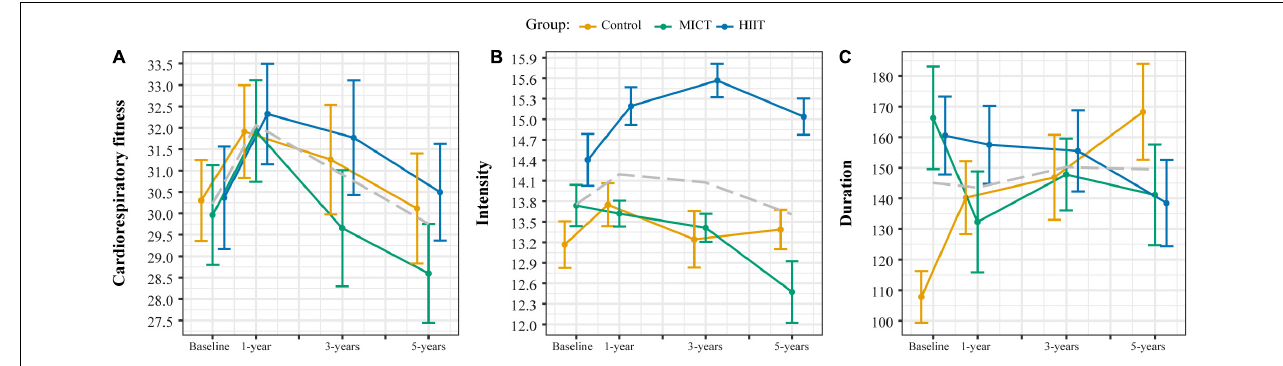
FIGURE 2 | Cardiorespiratory fitness (A) , exercise intensity (B) measured with the Borg 6–20 scale, and exercise duration (C) measured as minutes per week in the control, moderate-intensity continuous training (MICT), and high-intensity interval training (HIIT) groups at each time point. The gray dashed line represents the mean for the whole